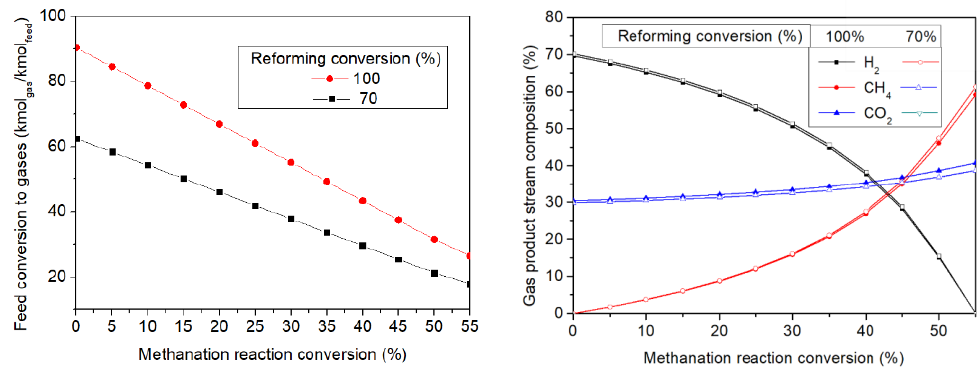
Figure 4. Gas production and composition (dry basis) at the APR reactor.